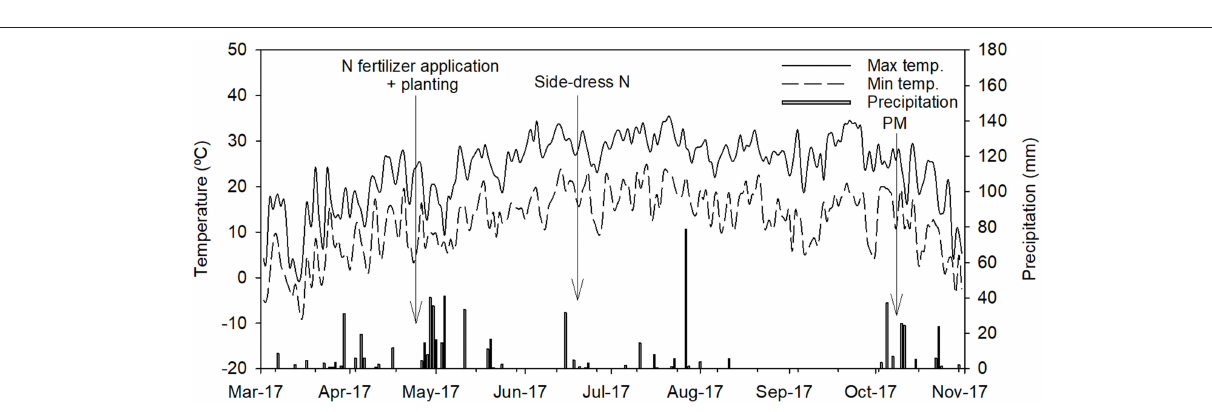
Soil samples for NO 3 -N and NH 4 -N determination